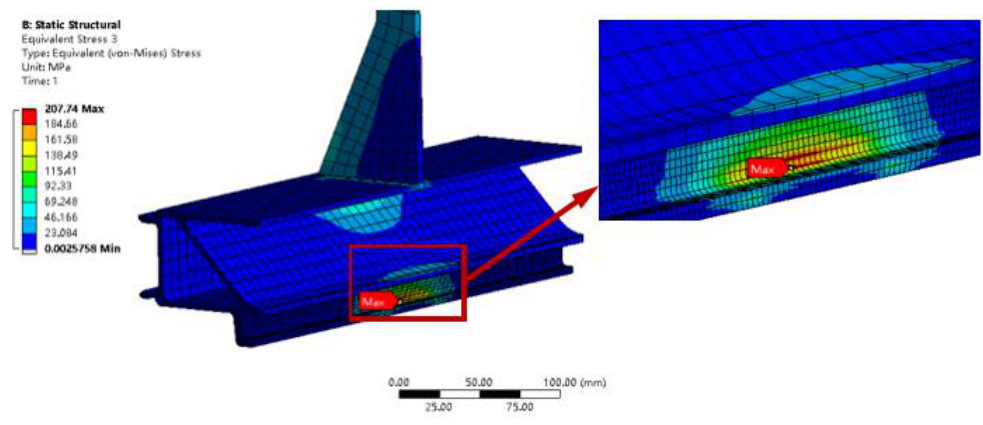
Figure 7. Location of the local maximum stress point.